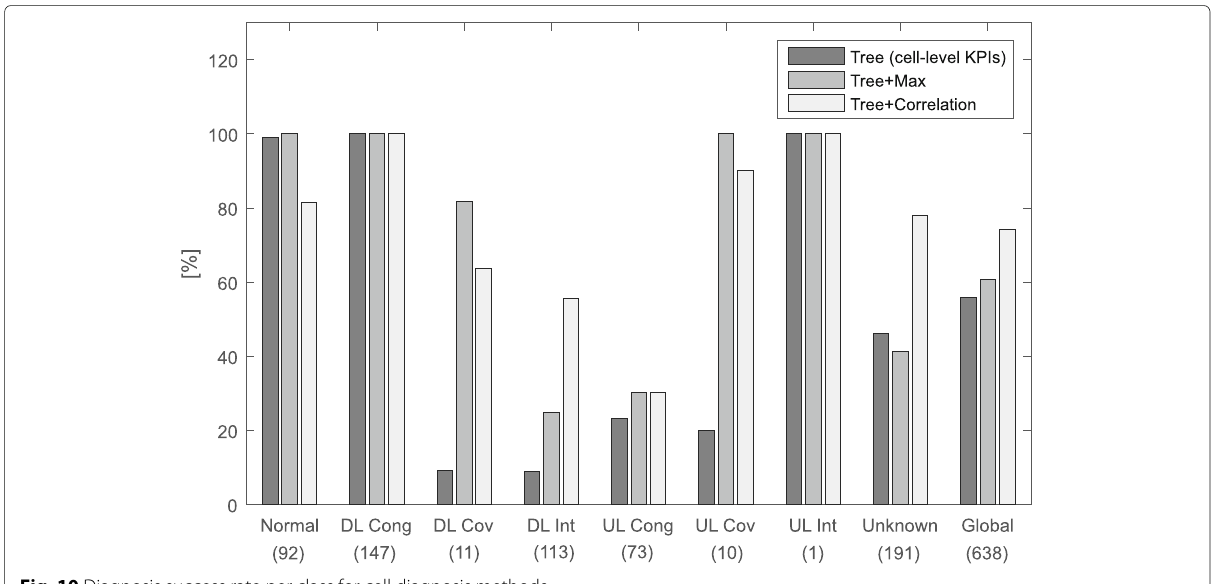
Fig. 10 Diagnosis success rate per class for cell diagnosis methods